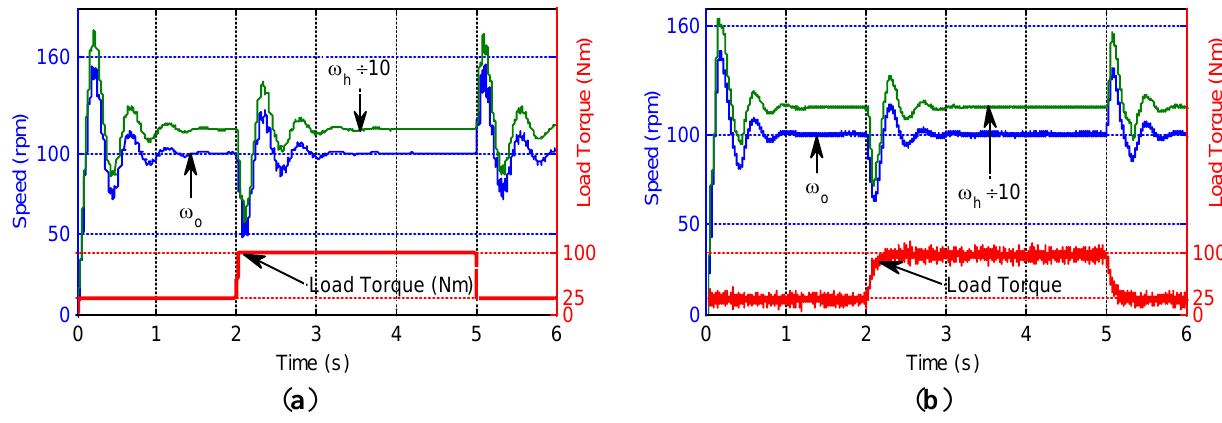
Figure 14. PDD speed responses under PI. ( a ) Simulated; ( b ) Measured.